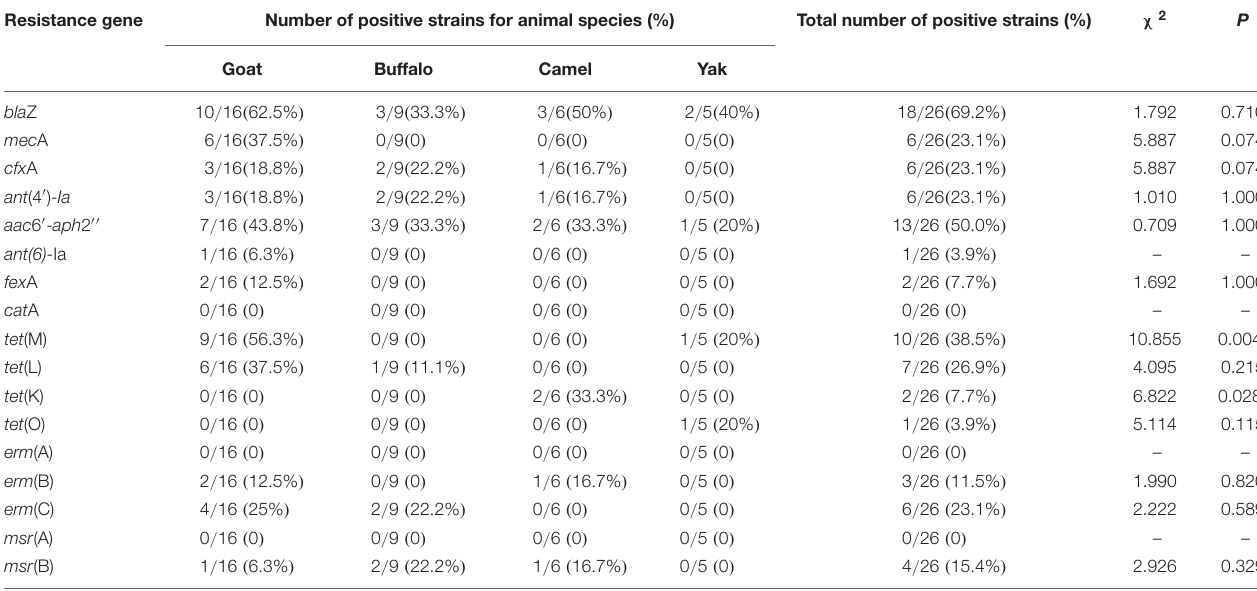
TABLE 2 | Antimicrobial resistance genes identified in S. aureus from different raw milks. Resistance gene Number of positive strains for animal species (%) Total number of positive strains (%)